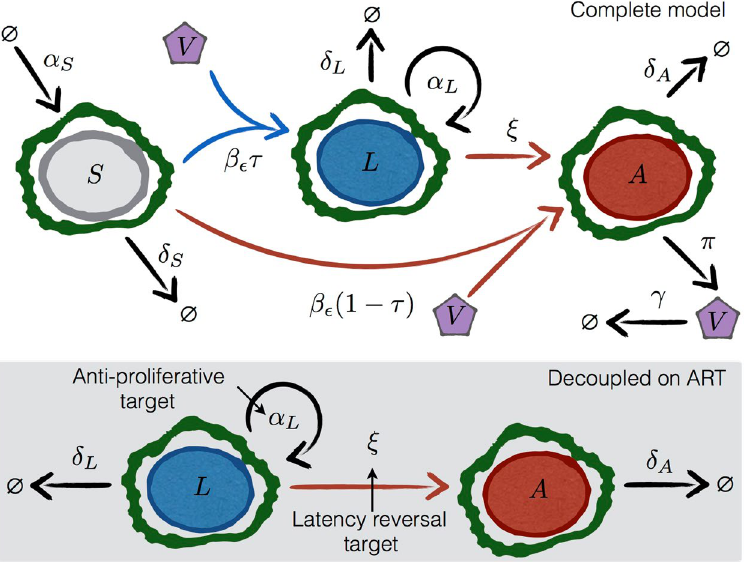
Figure 1. Schematics of models for HIV dynamics on and off ART. The top panel shows all possible transitions in the model (equation (1)). The bottom shaded panel shows the available transitions for the decoupled dynamic equations when ART suppresses the virus. Model parameters are given in Table 1. HIV virus V infects susceptible cells S at rate β reduced by ART of efficacy ε to β ε . The probability of latency given infection is τ . The rate of activation from latently infected cells ( L ) to actively infected cells ( A ) is ξ . Cellular proliferation and death are determined by rates α and δ for each compartment. The mechanisms of action of anti-proliferative and latency reversal therapies are to decrease α L and increase ξ , respectively.